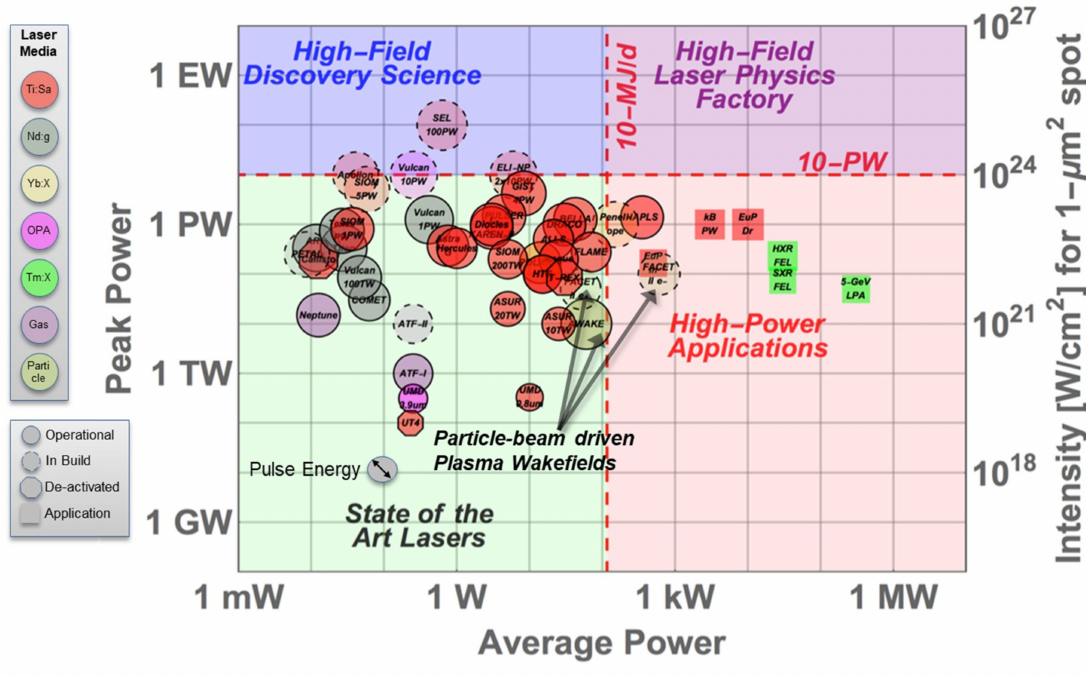
Figure 1. Current high-peak-power lasers and particle drivers for wakefield accelerator experiments, and some stated LWFA